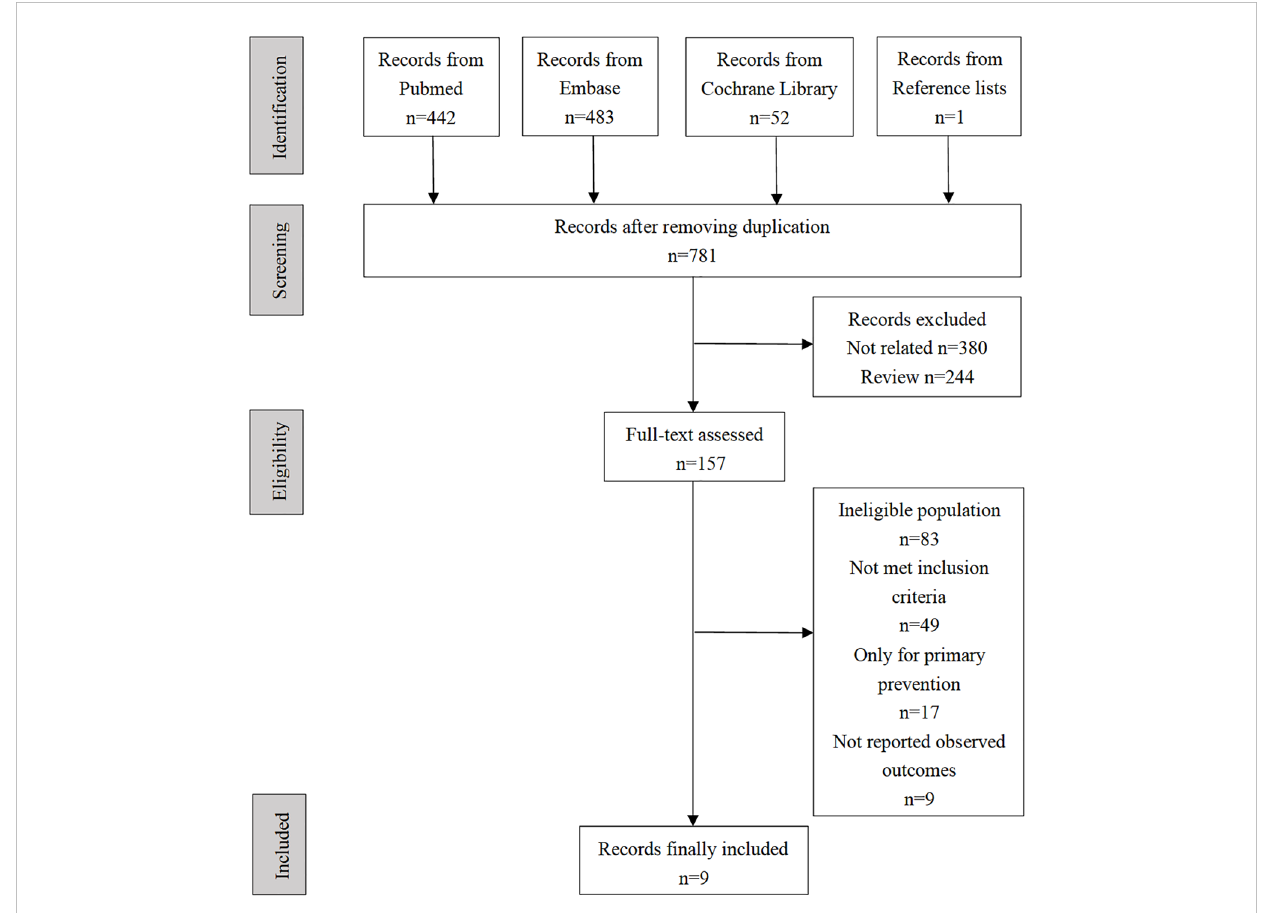
FIGURE 1 Flowchart of screening eligible